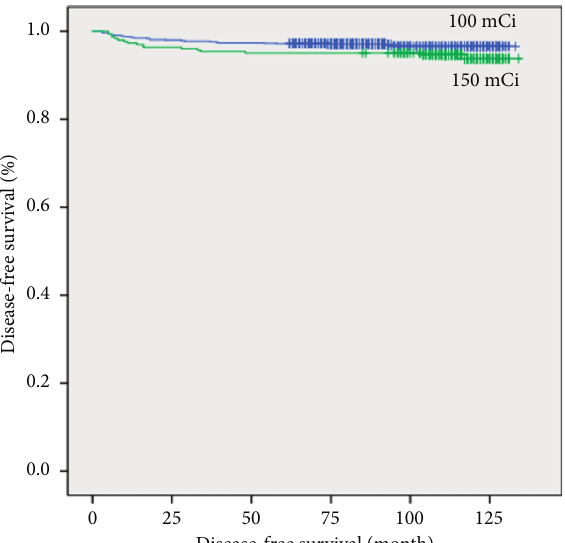
Figure 1: Disease-free survival curves of intermediate-dose (100mCi) and high-dose (150mCi) groups before propensity score matching ( p � 0 .